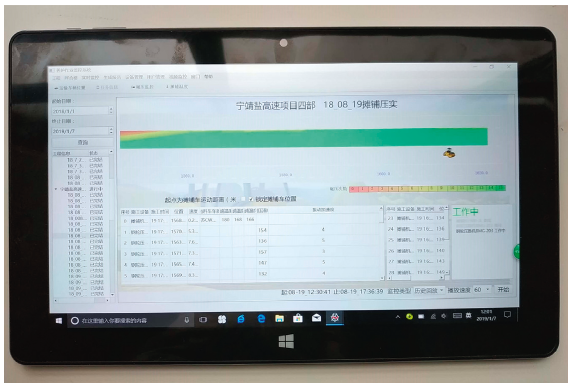
Figure 3: Designed processor unit and